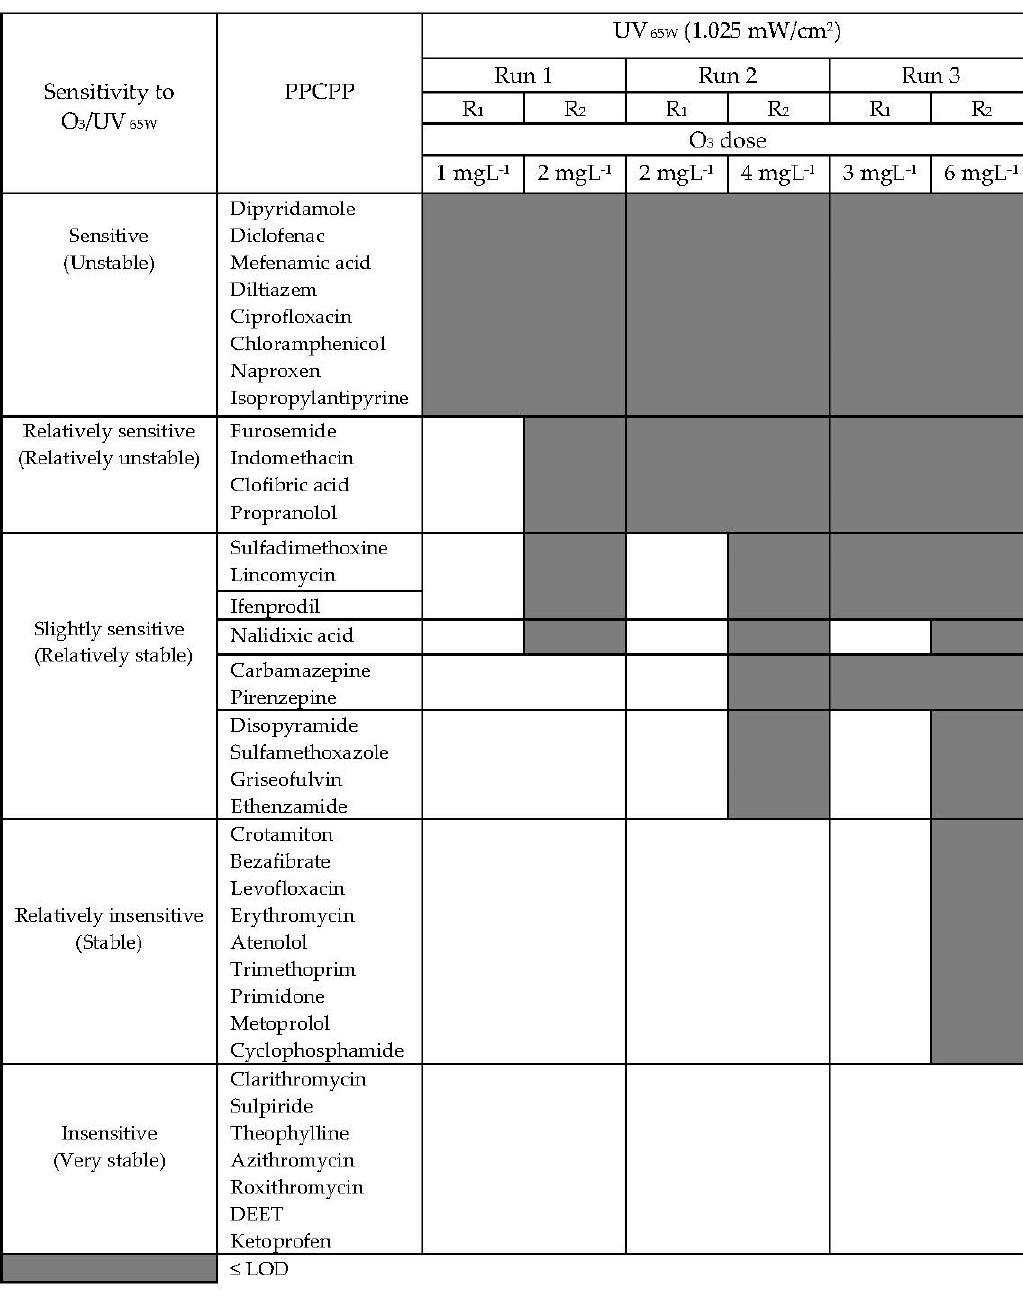
Figure 9. Degradability of 38 PPCPs in the two flow-through O 3 /UV 65W reactors in series (R 1 , R 2 ).